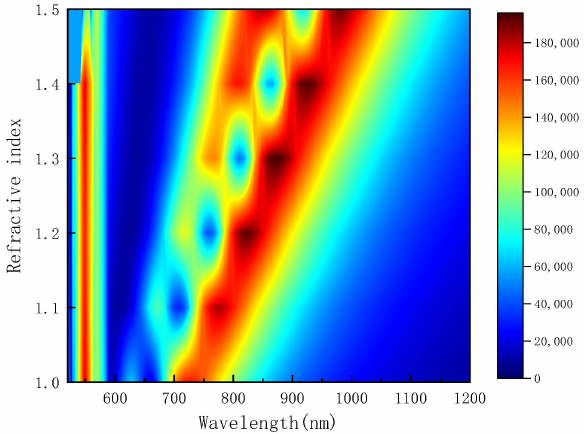
Figure 7. Effects of refractive indexes on the scattering